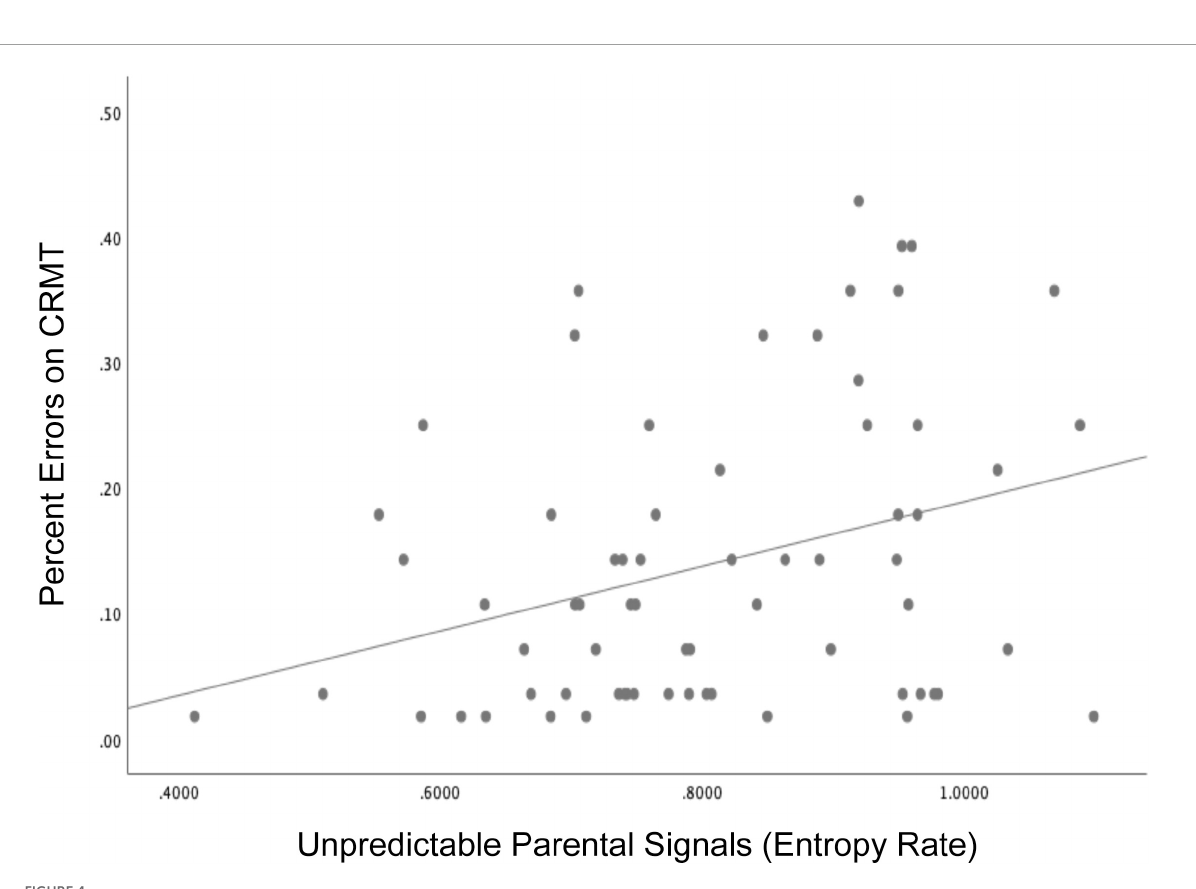
FIGURE4 Children who were exposed to more unpredictable parental signals (higher entropy rate) during infancy (6 and 12 months) showed poorer memory performance indicated by more errors on the Continuous Recognition Memory task (CRMT) at 6.5 years of age, r = –0.316, p <